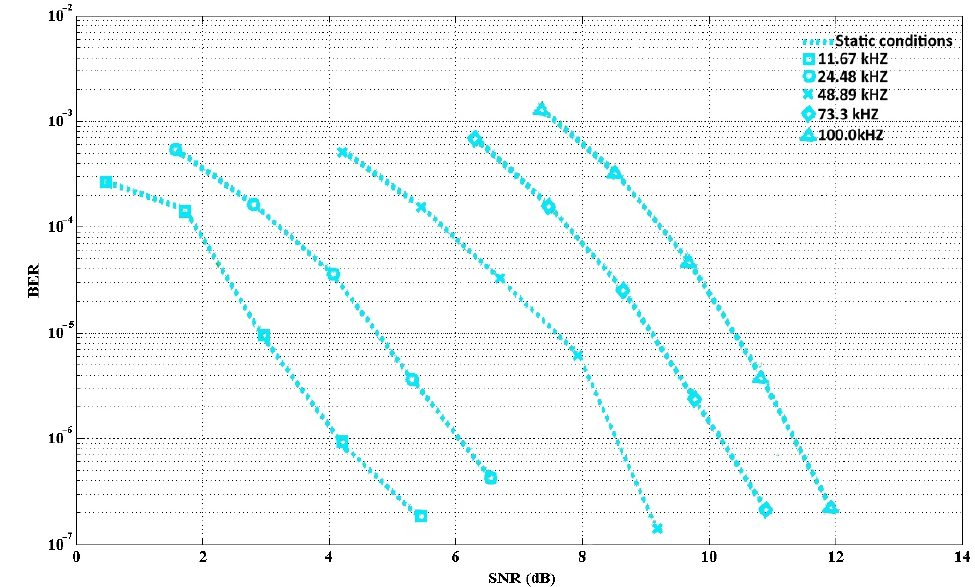
Figure 10. BER for several frequencies (static